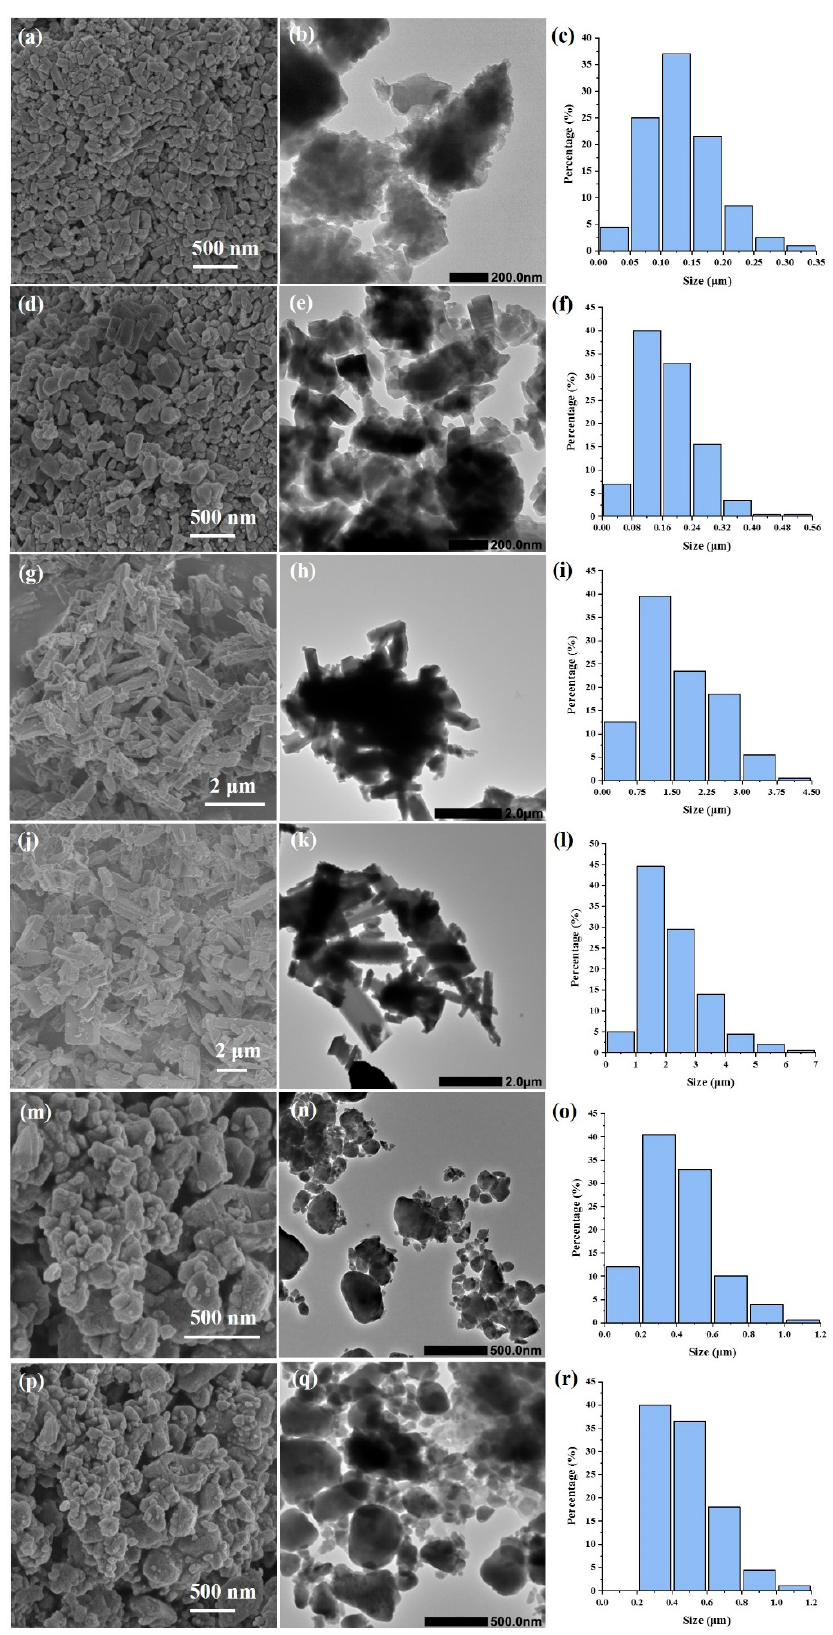
Figure 2. The scanning electron microscopy (SEM) micrographs, transmission electron microscopy (TEM) images, and distribution curves of the crystallite sizes of the ZSM-5 zeolites: ( a – c ) I; ( d – f ) II; ( g – i ) III; ( j – l ) IV; ( m – o ) III-b.m.; ( p – r ) IV-b.m.